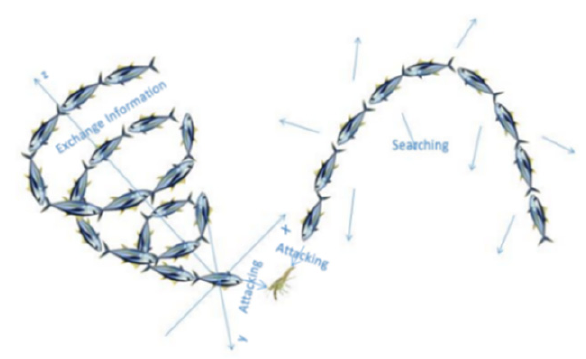
Figure 1. Search mechanism of TSO.